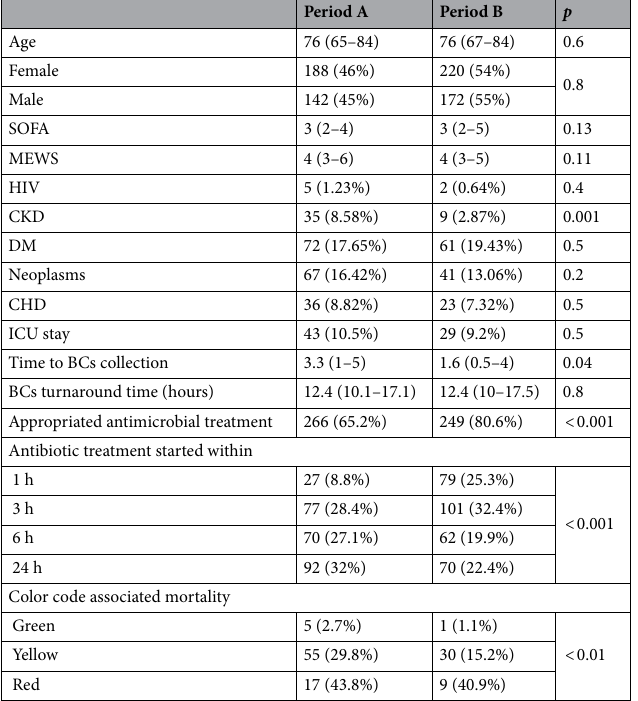
Table 1. Patients’ general characteristics. SOFA sequential organ failure assessment, MEWS modified early warning score, HIV human immunodeficiency virus, CKD chronic kidney disease, DM diabetes mellitus,